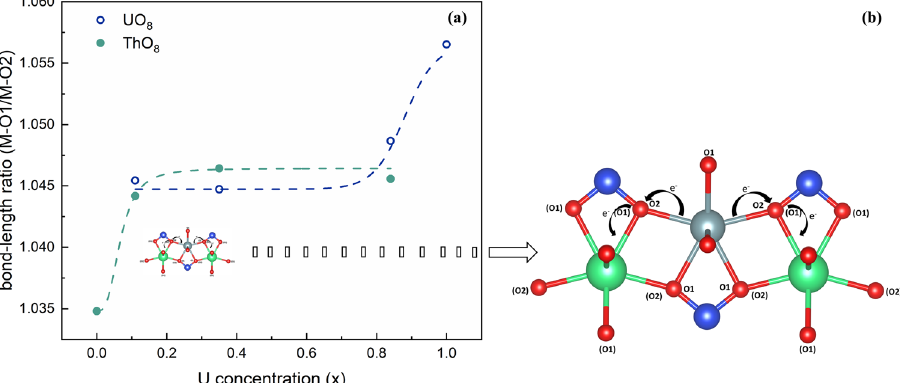
Fig. 8 The electronic transfer interaction between Th- and adjacent U-dodecahedra. a The bond-length ratio (<M – O1>/<M – O2>) for M = U or Th, as a function of the U concentration x . Bond lengths of <M – O1> and <M – O2> were obtained from RMC- fi tted atomistic models. b Conceptual representation of electronic transfer interaction between Th- and adjacent U-centered dodecahedra, where the gray spheres are U, the green spheres are Th, the blue spheres are Si, and red spheres are